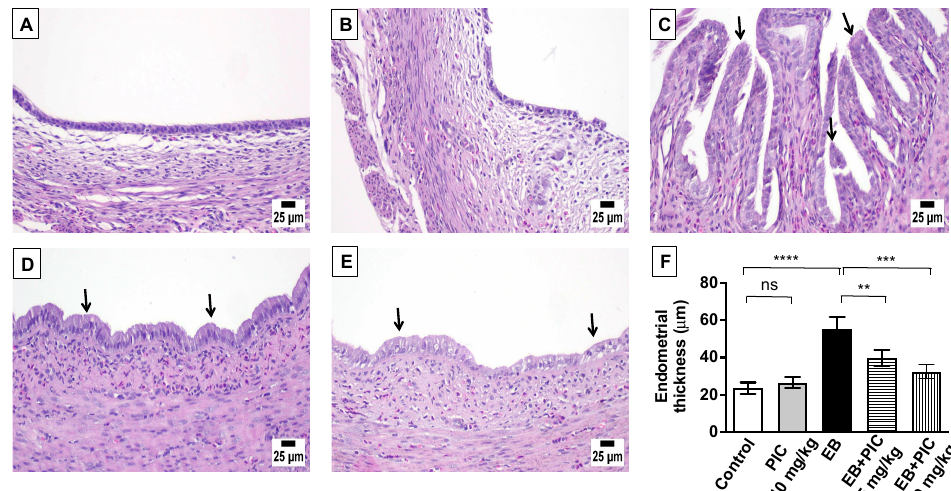
Figure 2. Effect of piceatannol SNEDDS on uterine histopathology in EB-induced EH in rats. Shown are uterus sections stained with Hematoxylin and eosin (H&E) from the following groups: ( A ) control group showing the normal histoarchitecture of the uterus; ( B ) piceatannol SNEDDS (PIC) 10 mg/kg group with no observable histological changes; ( C ) estradiol benzoate (EB) 0.6 mg/kg group showing increased endometrium thickness with hyperplasia and intraluminal papillary projections; ( D ) EB group co-treated with PIC (5 mg/kg) showing reduction in hyperplasia and projections; ( E ) EB group co-treated with PIC (10 mg/kg) showing a clear reduction in hyperplasia and projections. Arrows point to intraluminal papillary projections. Panel ( F ) represents a graphical presenation of endometrial thickness. Dara are expressed as mean ± S.D ( n = 6). ns = not significant, ** p < 0.01, *** p < 0.001 and **** p < 0.0001 by one-way ANOVA with Tukey’s post hoc test.